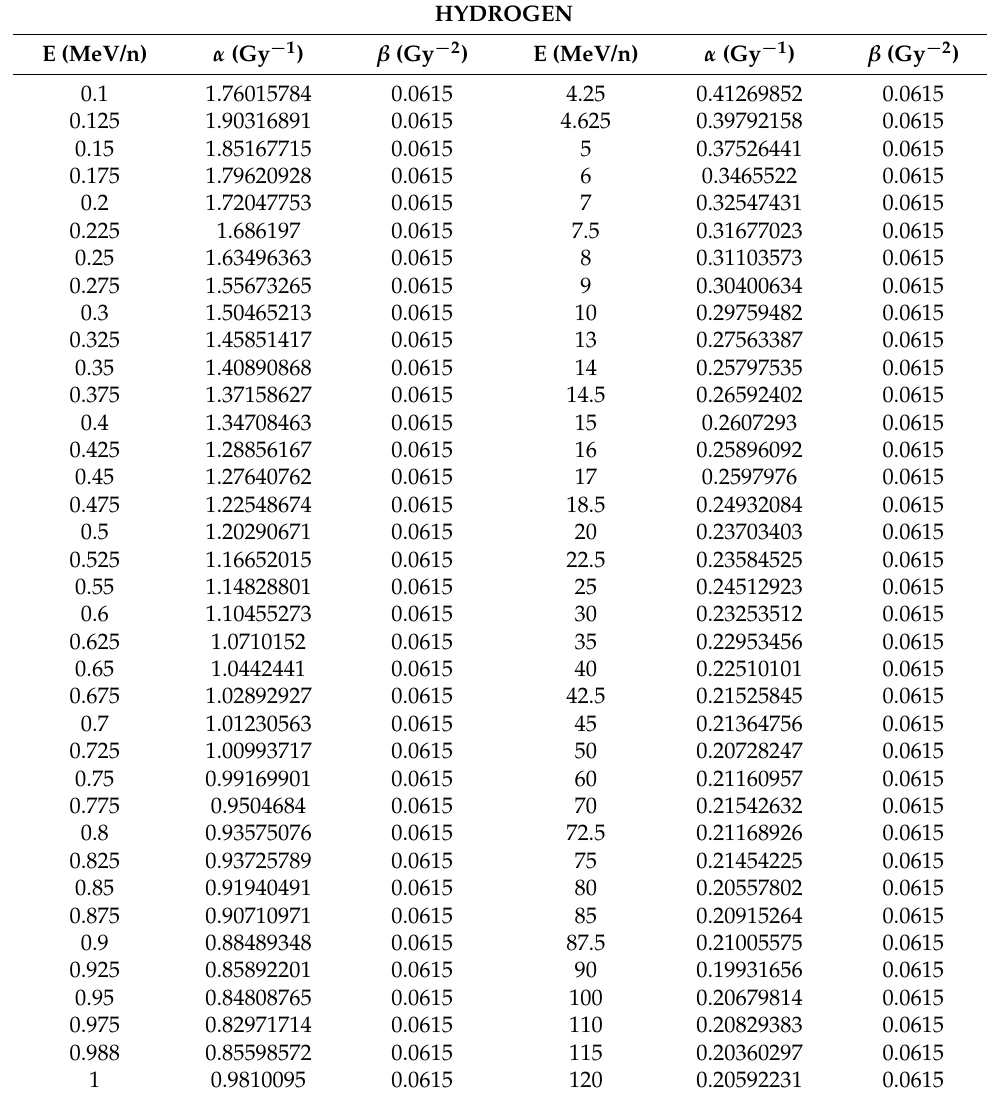
Table A2. Predictions of α and β Values for the HSG Cell Line in Response to Hydrogen, Helium, Carbon and Oxygen Ions for the mMKM